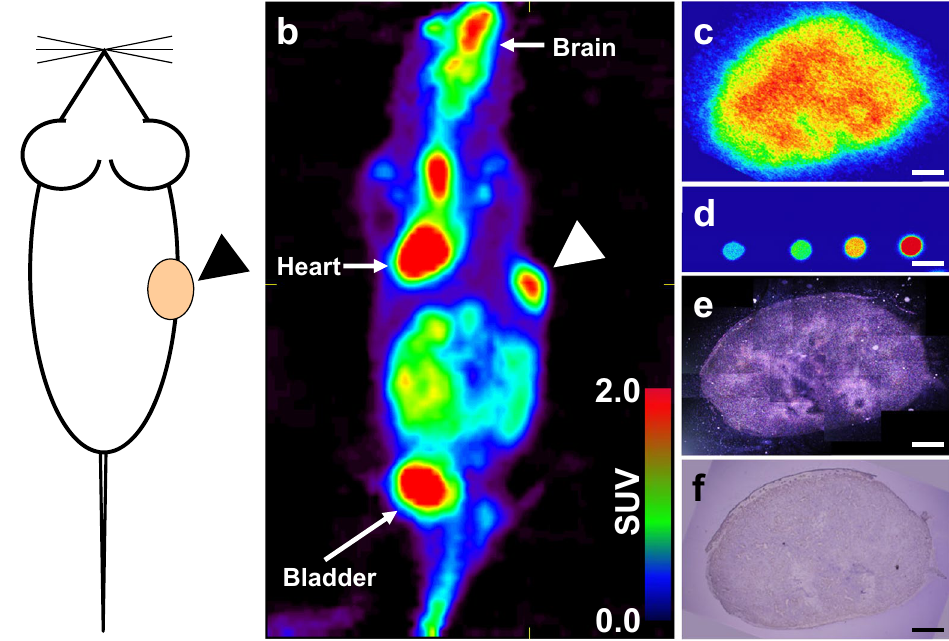
Figure 1. Multi-modal imaging of 18 F-FDG distribution in the A431 cell-derived tumor. ( a ) Illustration of tumor xenograft mouse. The arrow-head shows the location of the A431 cell-derived tumor. ( b ) Imaging to visualize tumor tissues using 18 F-fluorodeoxyglucose positron emission tomography ( 18 F-FDG PET) coronal view image of the A431 xenograft SCID mouse. The arrow-head shows the A431 cell-derived tumor. ( c ) Macro- autoradiography of an A431 cell-derived tumor section. ( d ) Macro-autoradiography of diluted dosage. The spots show 1 μL of 1:200-, 1:400-, 1:800-, and 1:1600-diluted injected dosages, from right to left. ( e ) The tiling image of micro-autoradiographs of a whole section adjacent to ( c ) in dark field observation. ( f ) HE staining of an adjacent section of ( c ). Bars: 1000